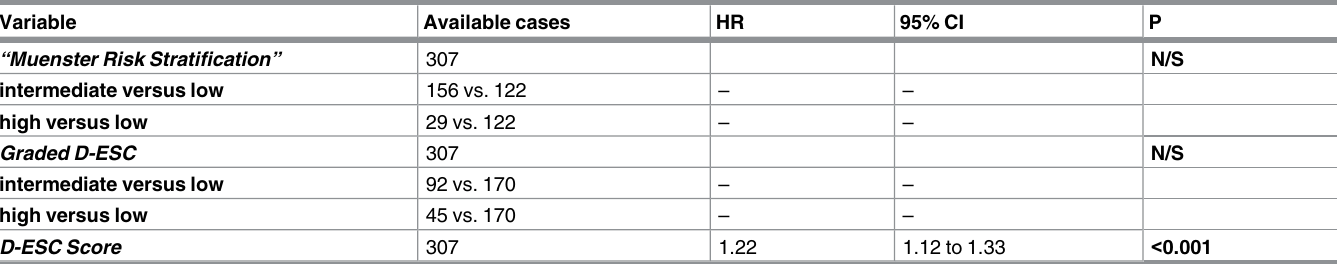
Table 7. Multivariable analysis for overall survival (comparison of